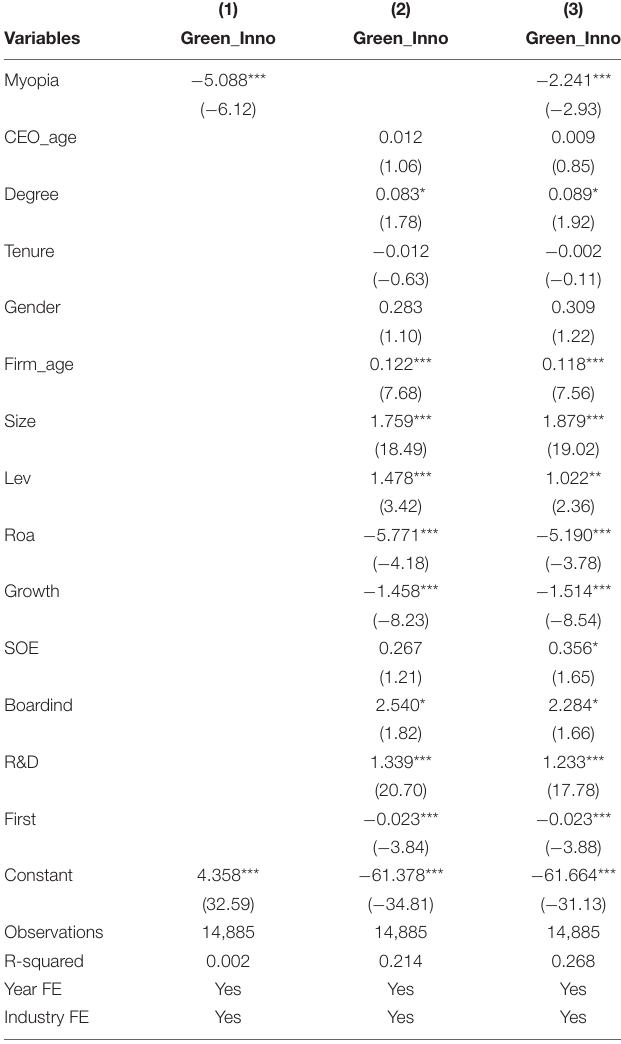
TABLE 4 | The impact of managerial myopia on green